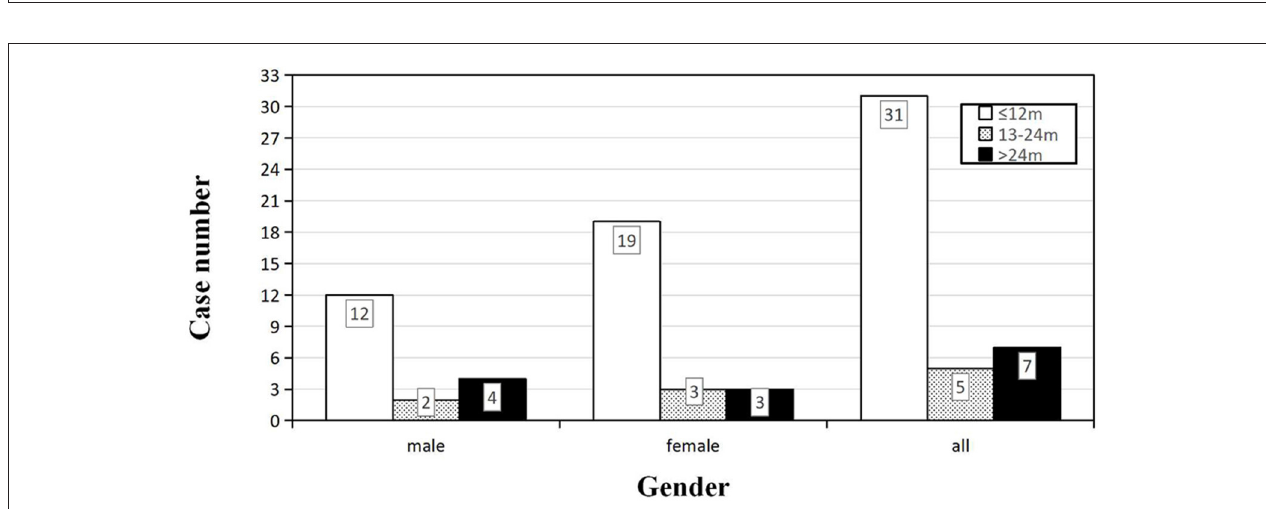
FIGURE 3 | Distribution of the survival time among sCJD patients stratified by onset age ( n = 43). Across all age groups, patients whose survival times were < 1 year tend to be the most, indicating that the survival time may not be necessarily related to the onset age.